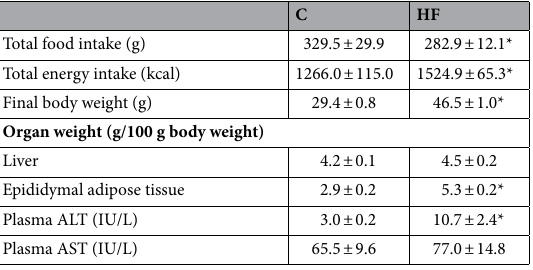
Table 1. Food intake, weights, and plasma transaminase activities. *Significant different from the values in control (Student’s t -test, P < 0.05, n =